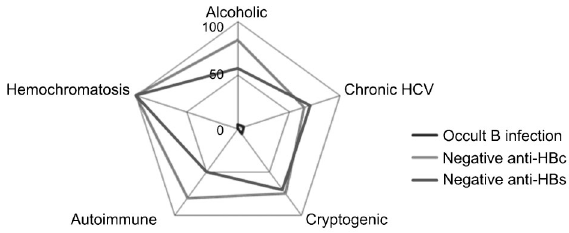
Figure 1. Radar chart summarizing the distribution of occult hepatitis B virus infection (OBI), hepatitis B core antibody (anti-HBc) and hepatitisB surface antibody (anti-HBs) according to the etiology of the underlying chronic liver disease. OBI was observed in association with alcohol, chronic hepatitis C virus (HCV) infection, and cryptogenic cirrhosis. Anti-HBc was negative in more than 50% of the patients with the different causes of cirrhosis. Anti-HBs was negative in 50% of the cases of autoimmune liver disorders and in more than 50% of the patients with the other causes of cirrhosis.